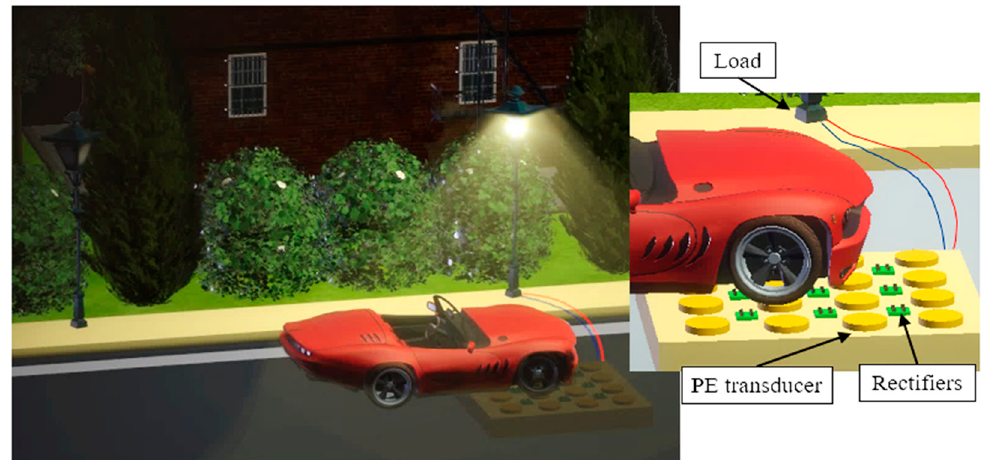
Figure 3. A streetlamp lightened up thanks to the pressure of a car on a slab of PE harvesters.